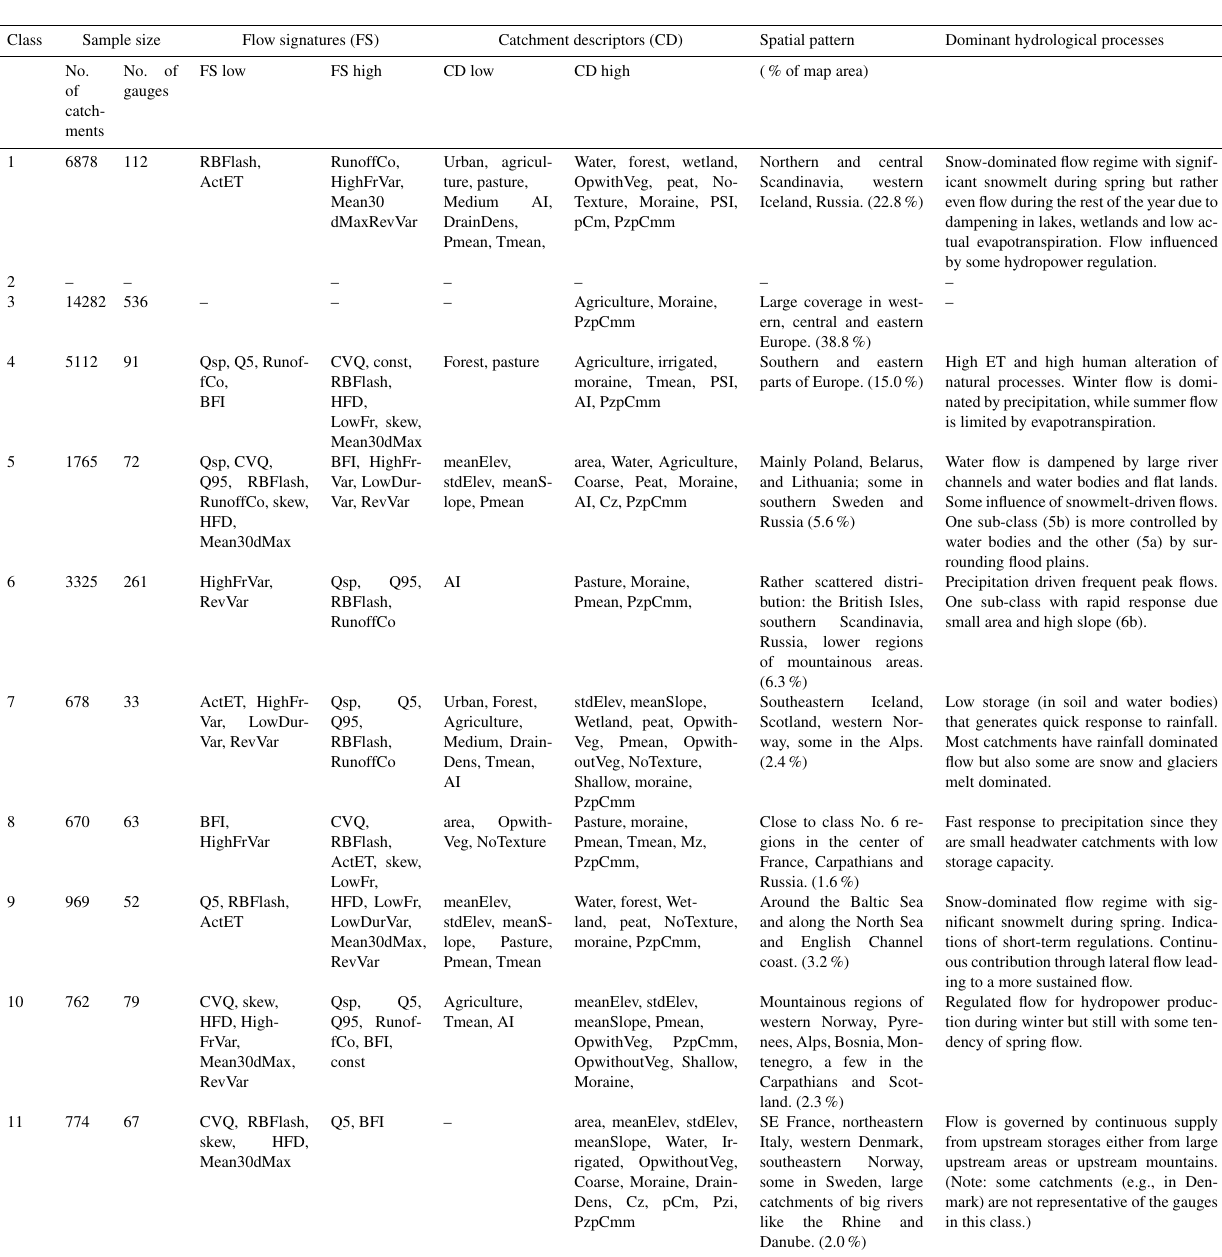
Table 3. Summary of findings when using the CART tree to classify catchments (CART classification shown in Fig. 3c) and extracting the main features for each cluster. Appointed flow signatures (Table 1) and catchment descriptors (Table 2) have median values in the 30% low/high percentile of the distribution over whole domain. Bold indicates median values in the 10% low/high percentile. Supporting figures with boxplots and matrices of flow signatures and catchment descriptors as well as detailed maps of spatial patterns are found in the Supplement (in Sects. C.1, C.2 and